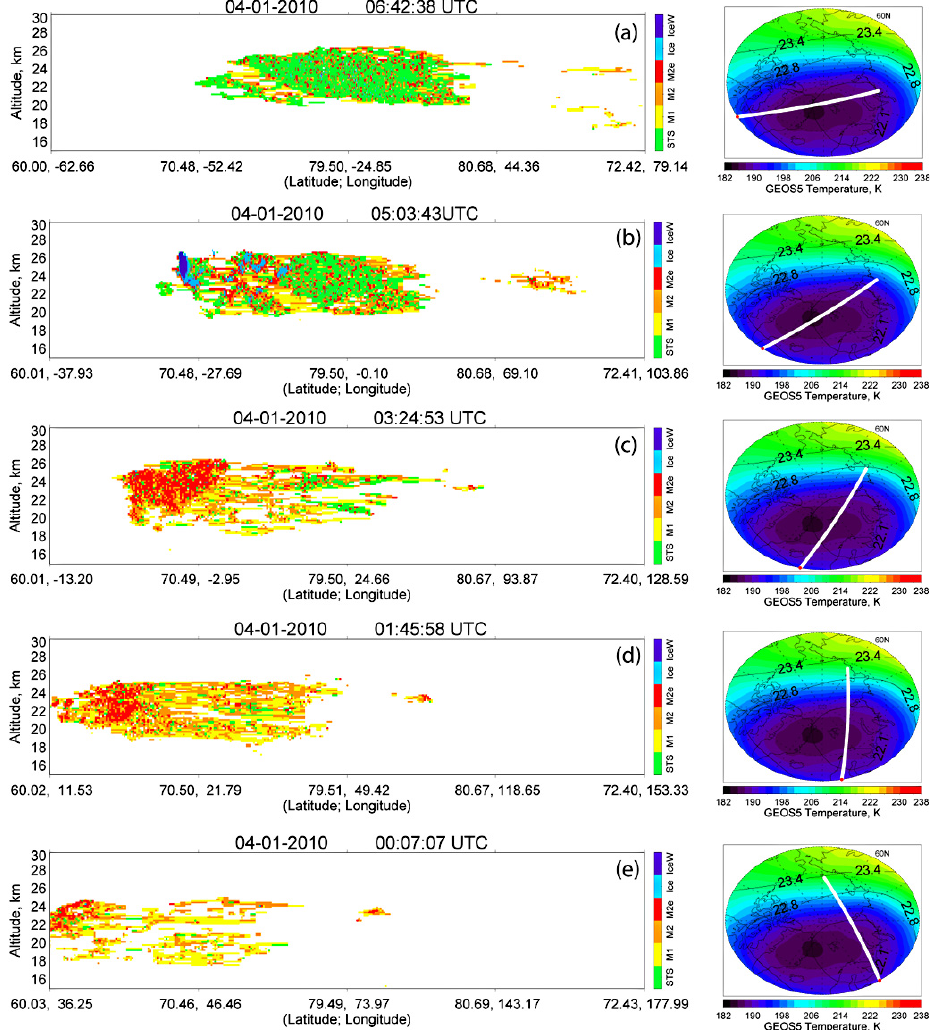
Fig. 13. Examples of CALIPSO PSC composition observations from five consecutive orbits during 4 January 2010. GEOS5 temperature and geopotential height fields at 30hPa for 12:00UTC are shown on the right with the location of the corresponding CALIPSO orbit tracks indicated by the white